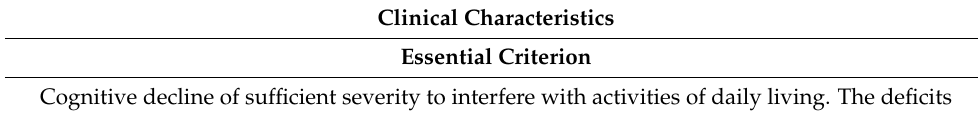
Table 1. Diagnostic criteria of DLB.